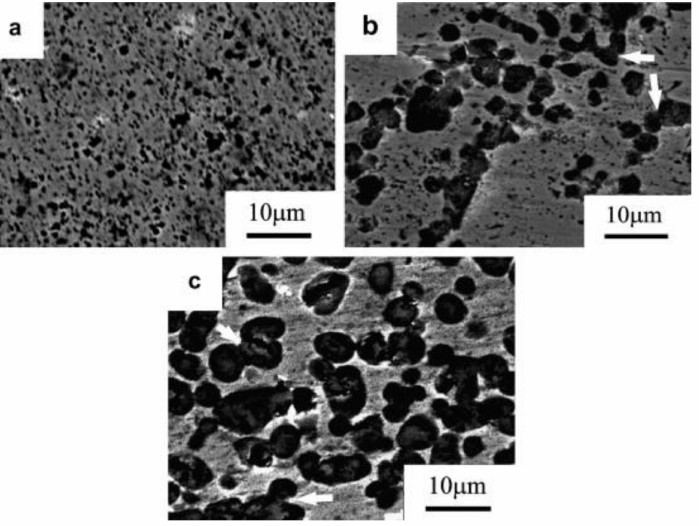
Figure 11. SEM images of Ni + Ti + C microstructures by LMD: 20 ( a ), 40 ( b ), and 60 ( c ) vol.% TiC [96]; with permission from